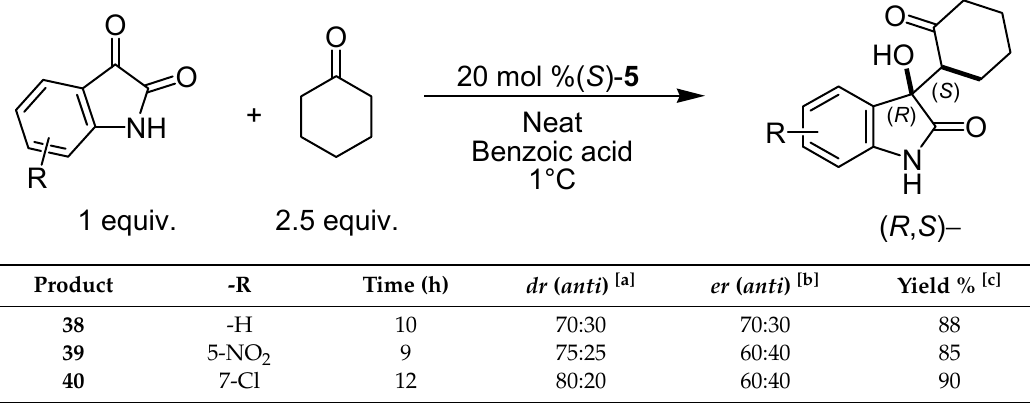
Table 4. Asymmetric aldol reaction between isatin derivatives and aromatic aldehydes catalyzed by ( S ) -5.